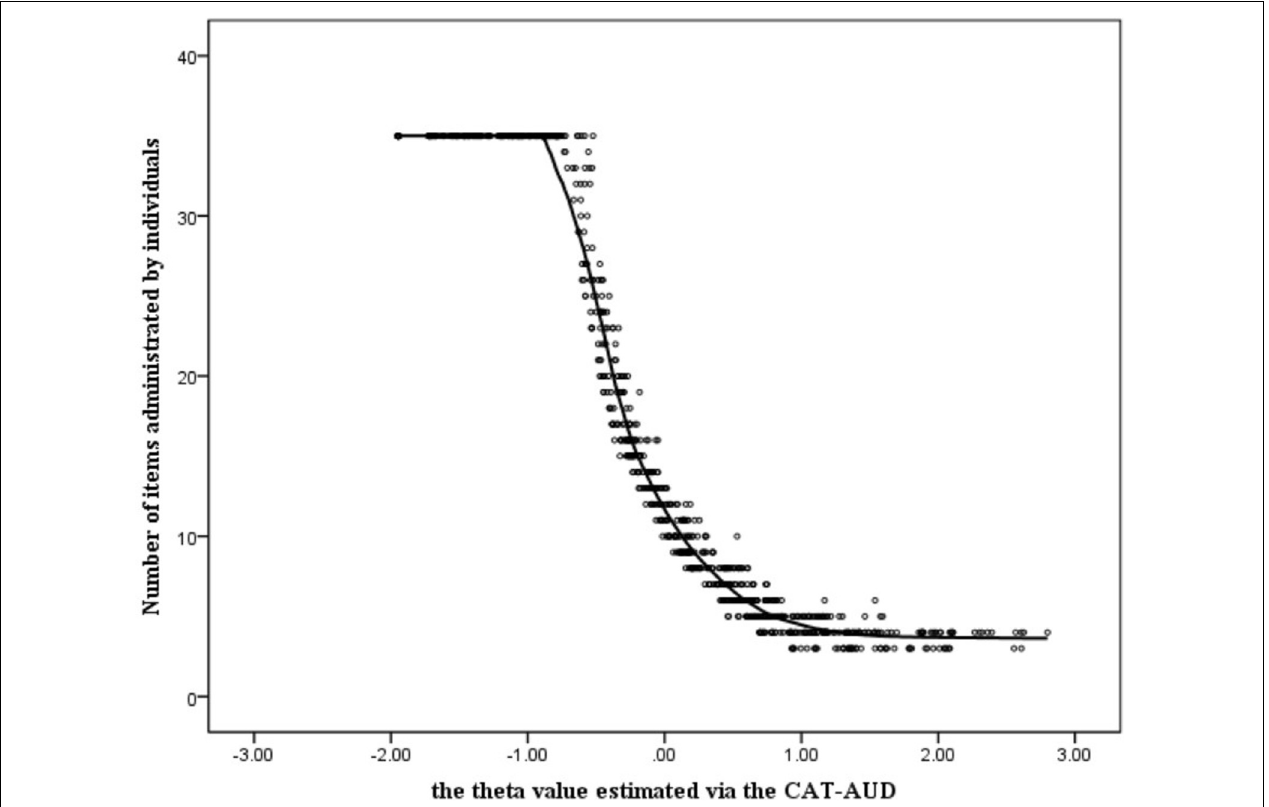
FIGURE 5 | Number of items administered by individuals in the CAT-AUD at a given SE level (SE ≤ 0.32).